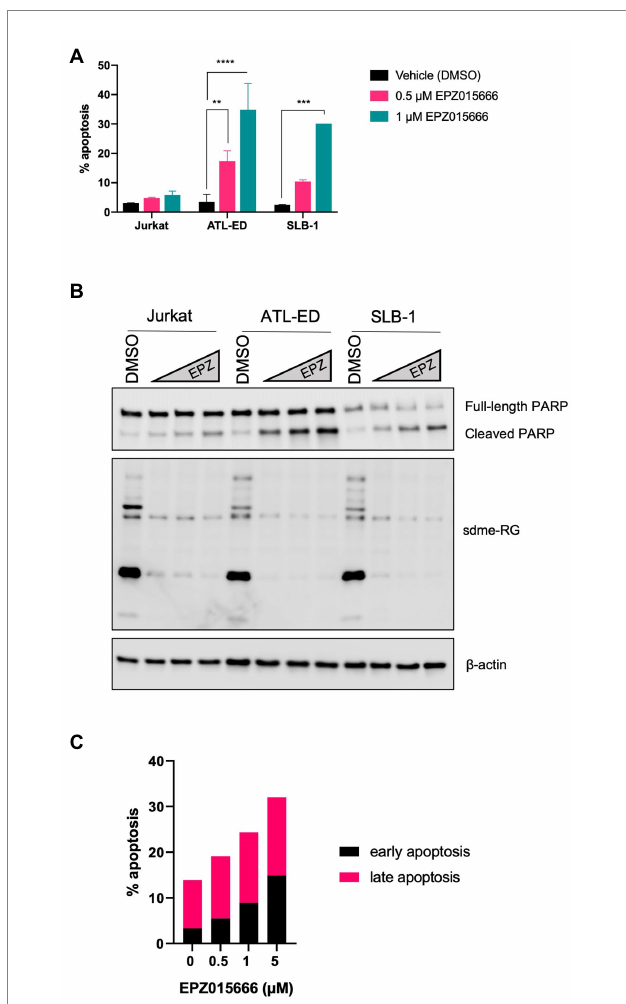
FIGURE 2 EPZ015666 treatment selectively increases apoptosis in HTLV-1- transformed cell lines. (A) Jurkat, SLB-1, and ATL-ED cells were treated with the indicated concentrations of EPZ015666. The level of total apoptosis was measured after 12 days of EPZ015666 treatment using a FITC Annexin V Apoptosis Detection Kit. Ordinary two-way ANOVA with Dunnett’s multiple comparison was used to determine significant differences between vehicle and EPZ015666-treated cells; p < 0.01 (**), p < 0.005 (***), p < 0.0001 (****). (B) Cell lysates were collected 4 days after EPZ015666 treatment and subjected to immunoblot analysis